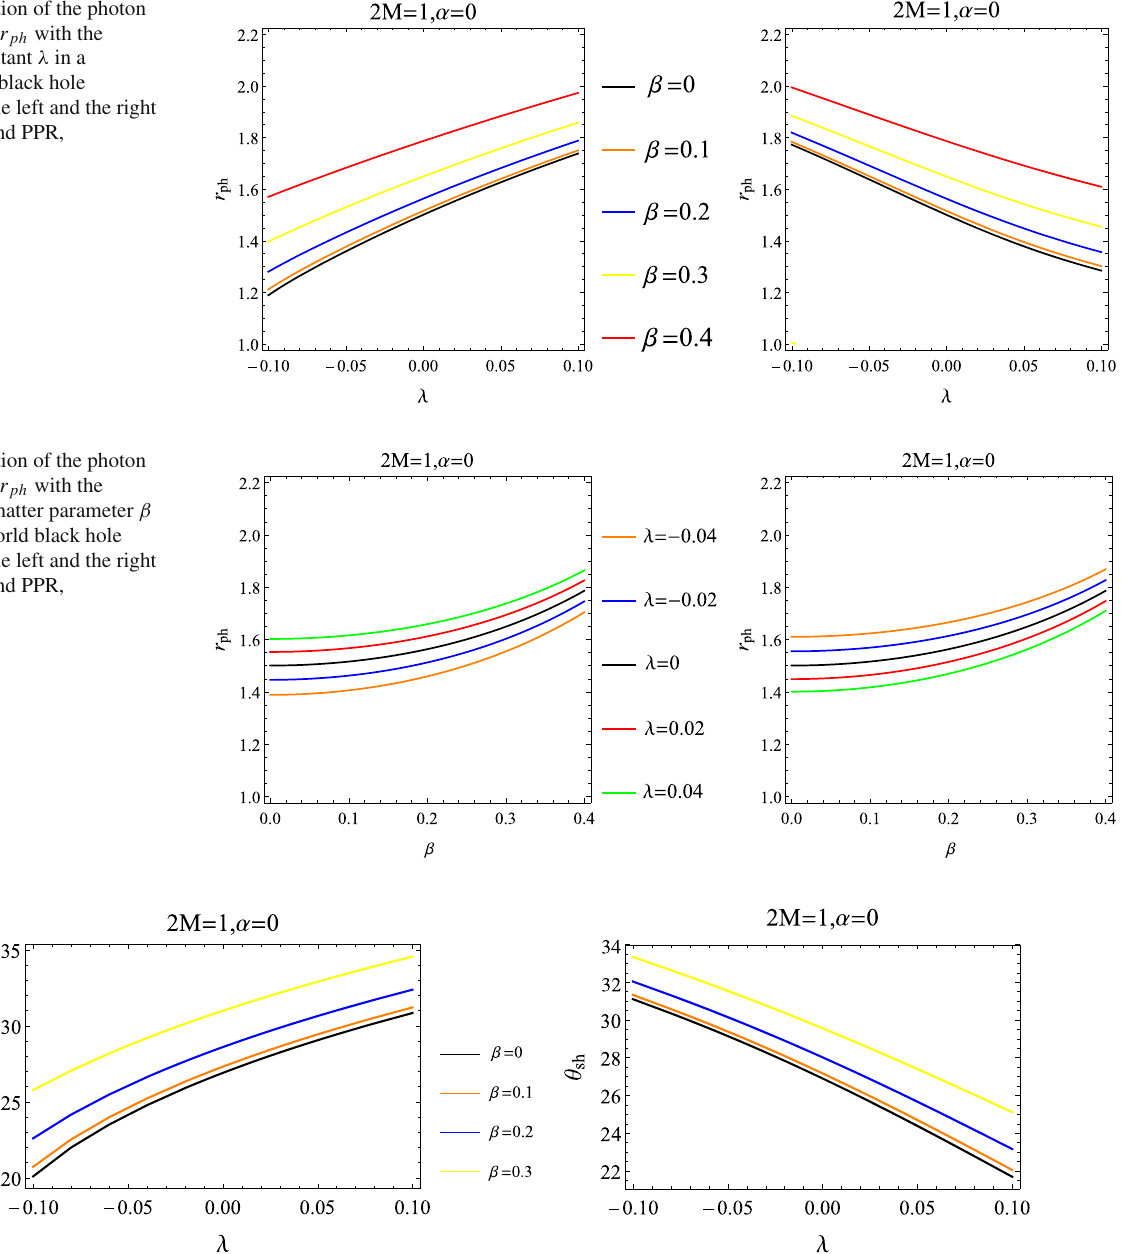
Fig. 3 Variation of the angular radius of the shadow with the coupling constant λ in a Brane-World black hole spacetime. The left and the right are for PPL and PPR,